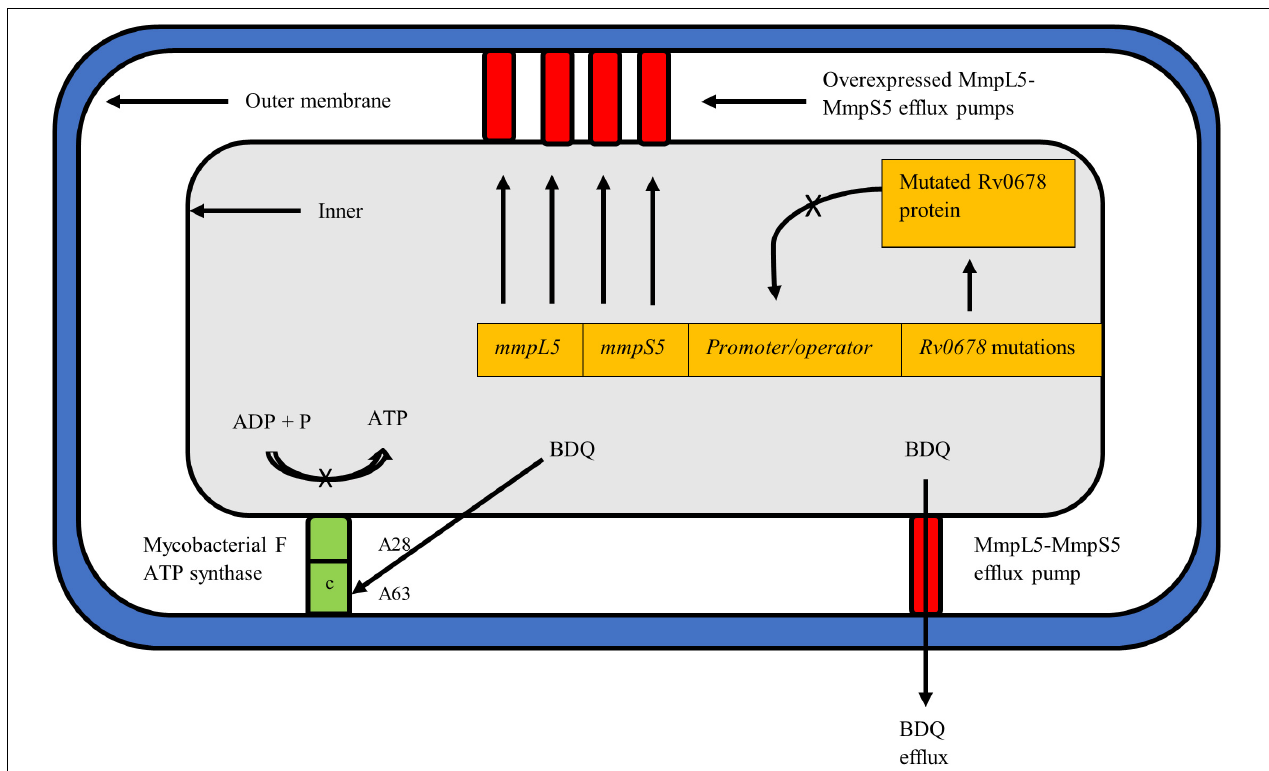
FIGURE 2 | Mycobacterium tuberculosis cell depicting the known resistance mechanisms against BDQ, i.e., atpE and Rv0678. The mechanism of action of pepQ, a cytoplasmic peptidase protein, remains to be elucidated. BDQ targets the c subunit of the ATP synth a se complex to inhibit ATP production and respiration of mycobacteria. Mutations such as A28 and A63 in atpE prevent BDQ binding to the complex, rendering the drug ineffective. The Rv0678 protein represses mmpS5 and mmpL5 genes to prevent transcription and expression of the MmpS5-MmpL5 efflux pump. A mutated and non-functional Rv0678 repressor cannot bind to the promoter/operator region thereby allowing over-expression of efflux pumps to expel more BDQ out of the mycobacterial